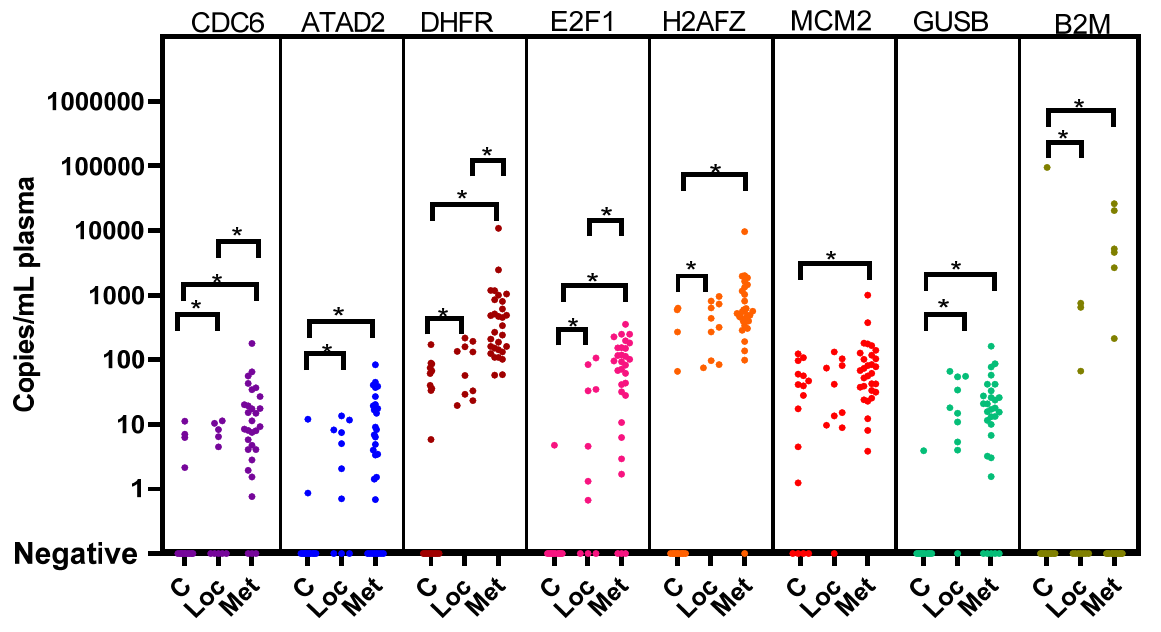
Figure 2. Expression of cell cycle genes ( CDC6 , ATAD2 , DHFR , E2F1 , H2AFZ and MCM2 ) and reference genes ( GUSB and B2M ) in cell-free RNA from healthy controls ( n = 40) and diagnostic plasmas from patients with neuroblastoma with localized ( n = 10) and metastatic ( n = 30) disease, as measured by ddPCR from 200 µ L plasma and corrected for platelet contamination. C; healthy controls. Loc; patients with localized disease. Met; patients with metastatic disease. * Signi fi cance at p < 0.05.